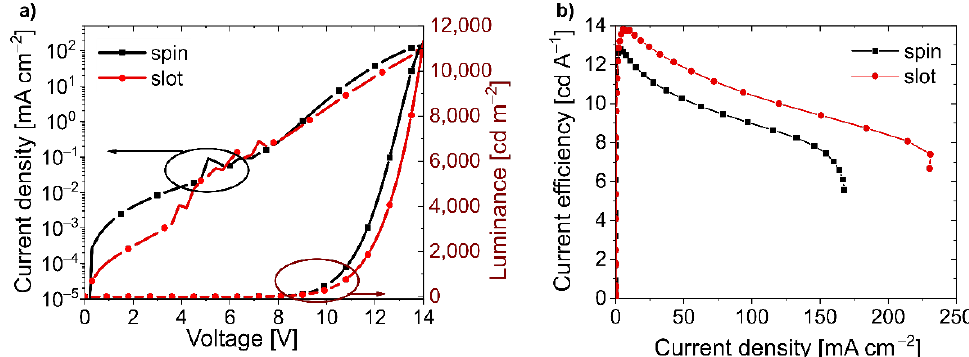
Figure 5. Working parameters of OLEDs with emissive layers prepared by spin- and slot-die coating techniques. Device structure: ITO/PEDOT:PSS(20 nm)/PVK:PBD + 2 wt.% Ir(75 nm)/TPBi(20 nm)/Liq (2 nm)/Ag (100 nm). ( a ) Current density – voltage characteristics (left) and luminance – voltage characteristics (right); ( b ) current efficiency vs. current density.